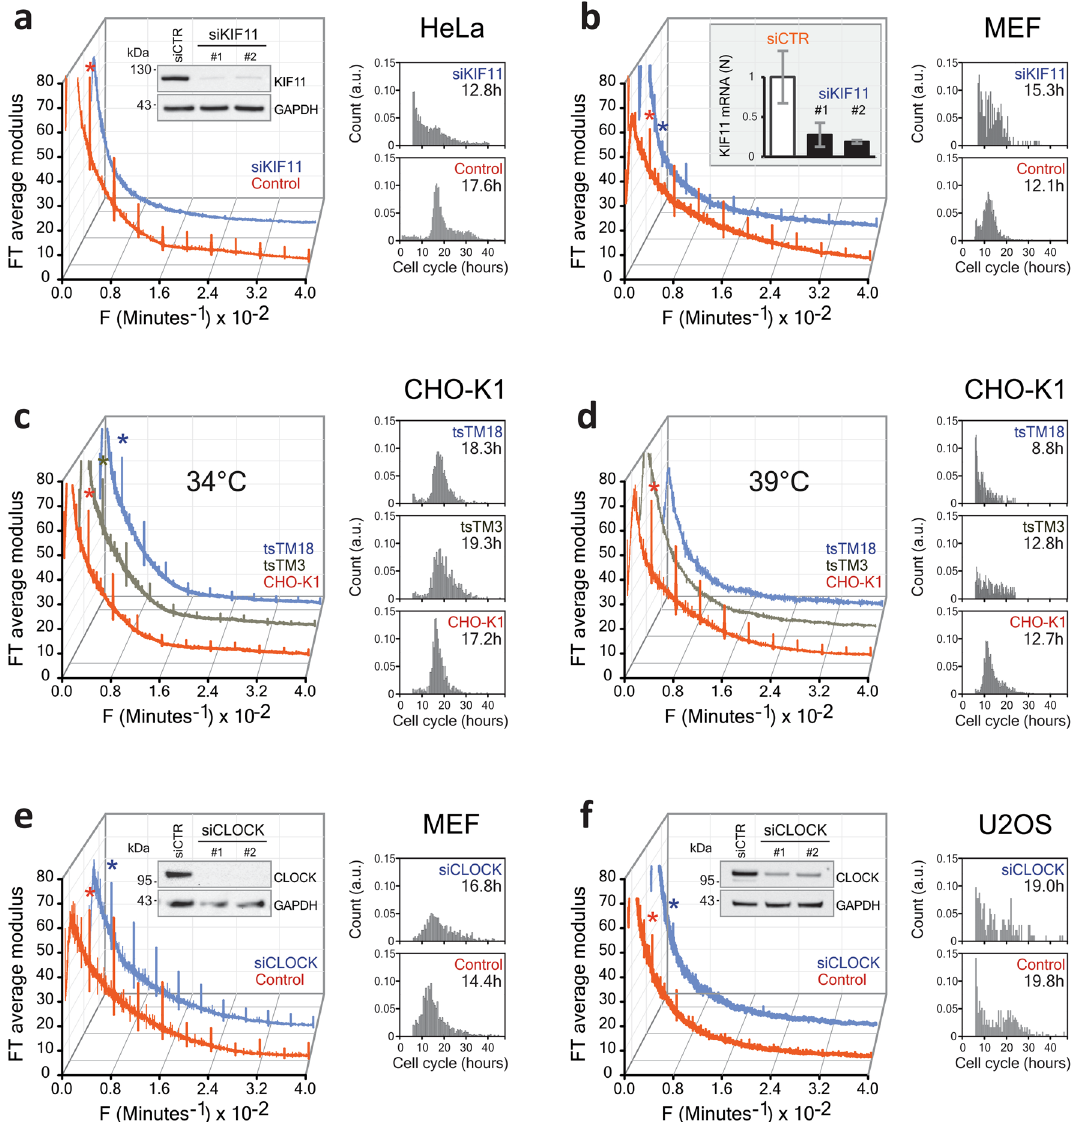
Figure 3. Relationship between the rhythm, cell cycle and circadian clock. ( a ) Cell cycle arrest by siKIF11 treatment in HeLa cells suppresses the 4 h rhythm. Western blots (in insert) confirm the inhibition of KIF11 expression (the effect of two specific siRNAs is compared to non-specific siCTR). ( b ) Incomplete cell cycle arrest by siKIF11 in MEF cells does not suppress the 4 h rhythm. Quantitative PCR analysis (in insert) shows the inhibition of KIF11 expression by two specific siRNAs in MEF. To the right of ( a ) and ( b ) we show the distributions of the cell cycle lengths corresponding to the two data sets. ( d ) Effects of cell cycle inhibition in temperature-sensitive CHO-K1 mutants at 39 °C, compared to the permissive 34 °C temperature ( c ). Cell cycle arrest in temperature-sensitive CHO-K1 mutants at 39 °C suppresses the 4 h rhythm. To the right of ( c ) and ( d ) we show the distributions of the cell cycle lengths for the three cell types. ( c ) Effect of circadian rhythm inhibition by siCLOCK in ( e ) MEF and ( f ) U2OS. Knocking down CLOCK does not eliminate the rhythm in MEF and U2OS. The Western blots (see inserts) show the inhibition of CLOCK expression by siCLOCK 1 and 2 in MEF and U2OS cells. To the right of ( e ) and ( f ) we show the corresponding distributions of the cell cycle